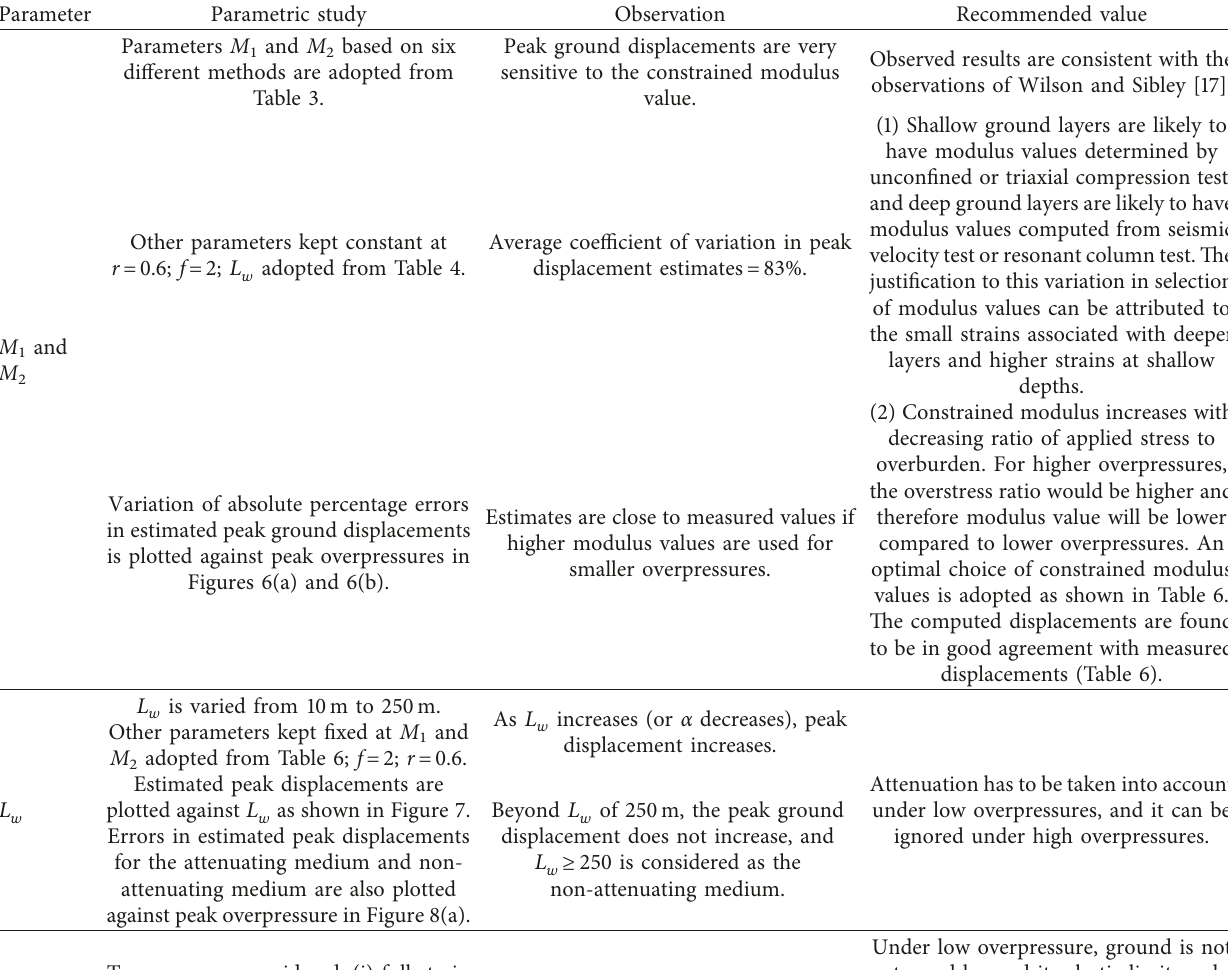
Table 5: Parametric studies carried out on the proposed closed-form